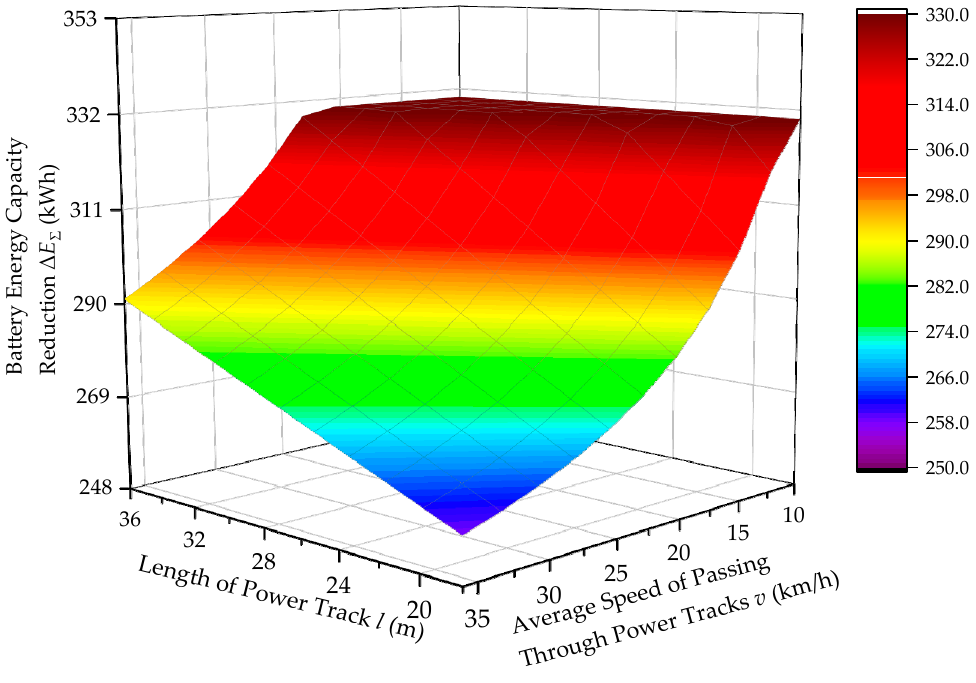
Figure 10. The effects of the length of power track and average speed of the bus passing through the power track on the battery energy capacity reduction.